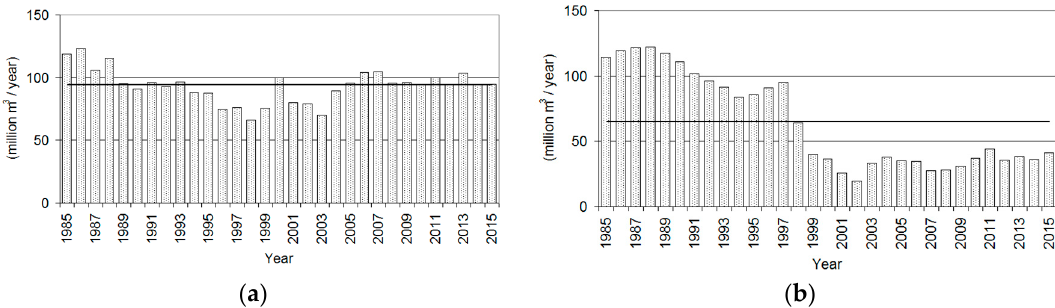
Figure 4. The amount of surface ( a ) and underground water ( b ) taken from the intakes of Zak ł ady Azotowe Pu ł awy used in the production of fertilisers 1985–2015.